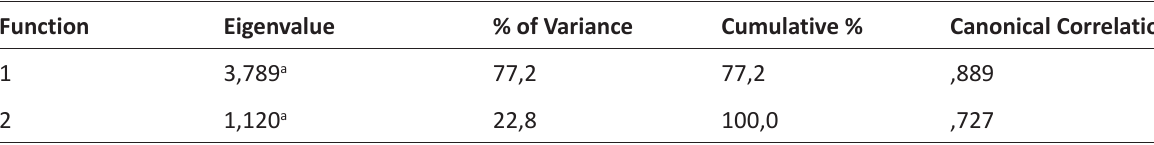
Table 2. Canonical discriminatory functions. Wilks’ Lambda. Boys of 11-13 years Test of